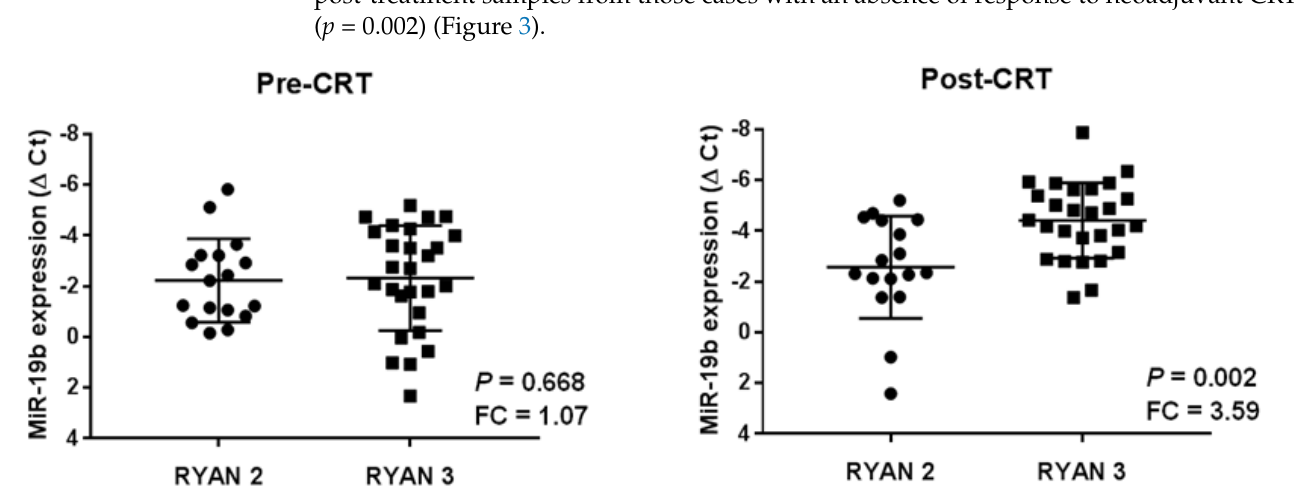
Figure 3. Dot-plots showing miR-19b expression in pre- and post-treatment samples from our cohort of LARC patients ( n = 44). FC = fold change. Patients with low and high miR-19b expression levels are indicated by black squares and circles, respectively.